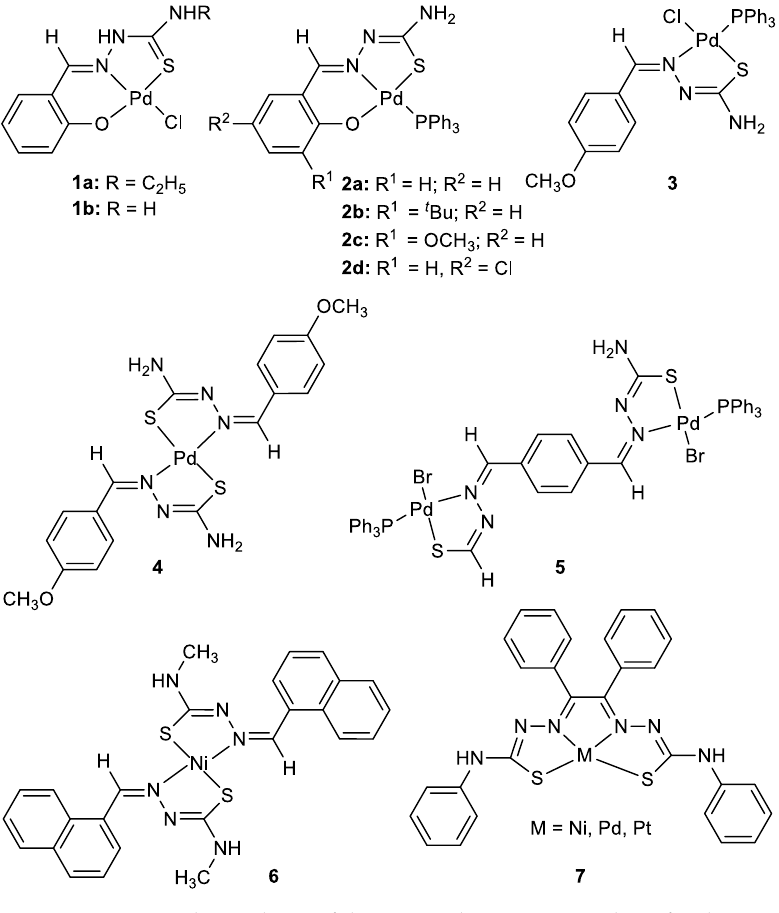
Figure 1. Representative metal complexes of thiosemicarbazones as catalysts for the Mizoroki – Heck and other coupling reactions.